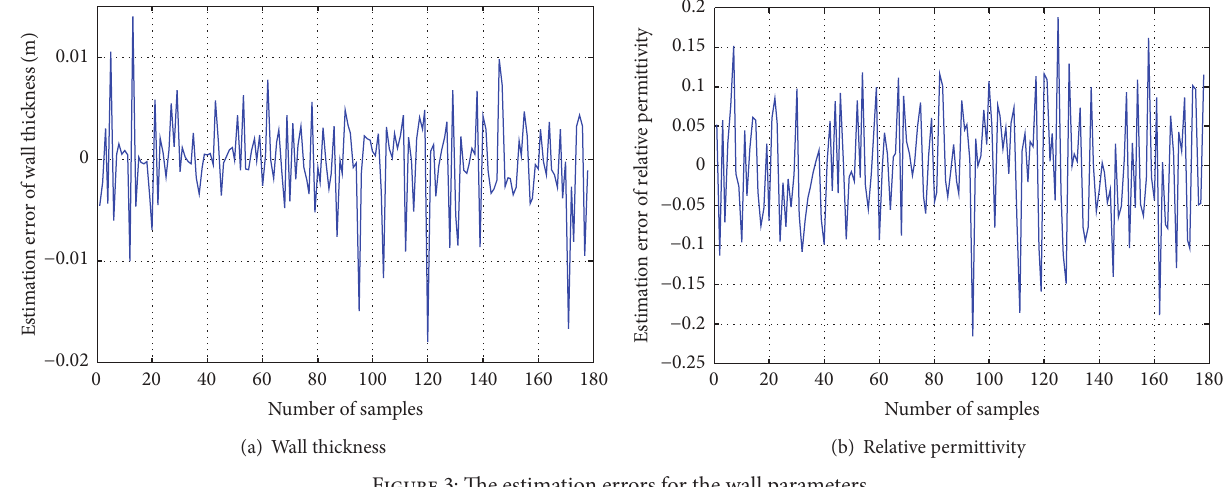
Figure 3: The estimation errors for the wall parameters.